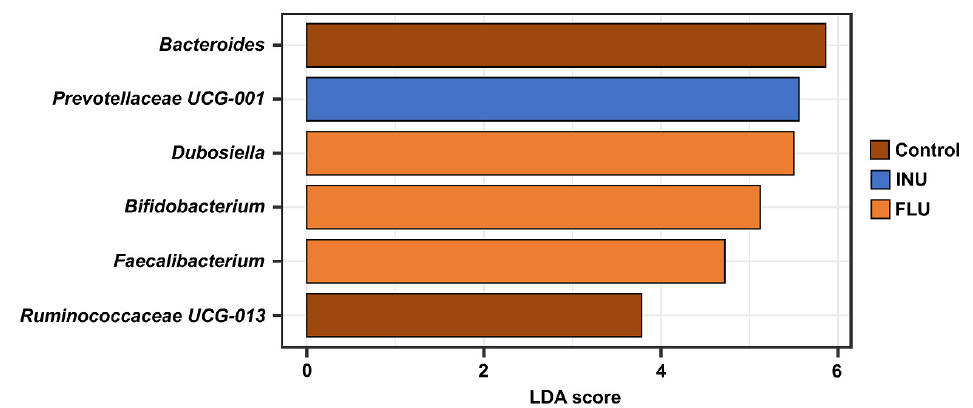
Figure 11. LEfSe analysis of the gut microbiota profiles grouped according to the treatment.